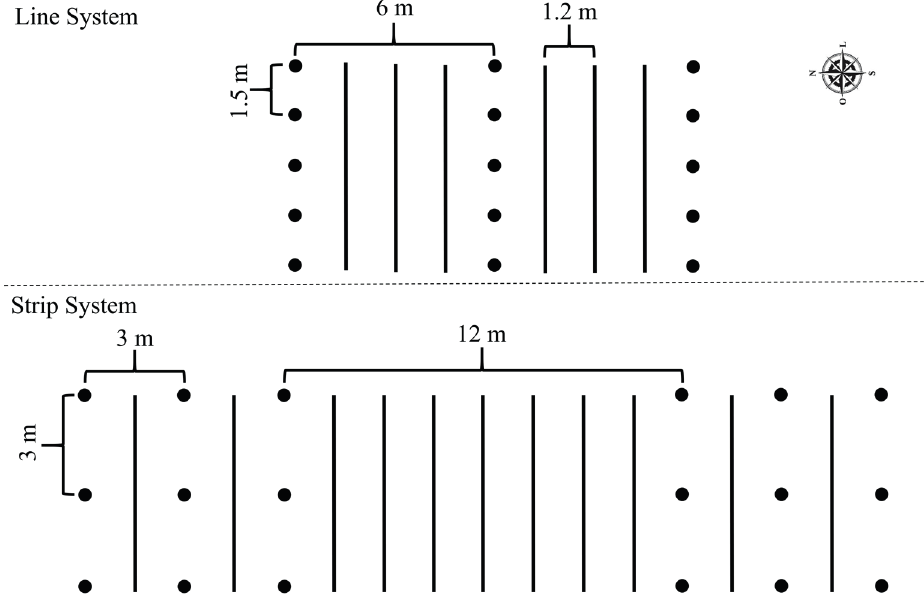
Figure 1 - A sketch of an experimental unit of line and strip systems. Black circles represent the trees; continuous lines indicate where the sugarcane was planted. Each species presented three experimental units in each